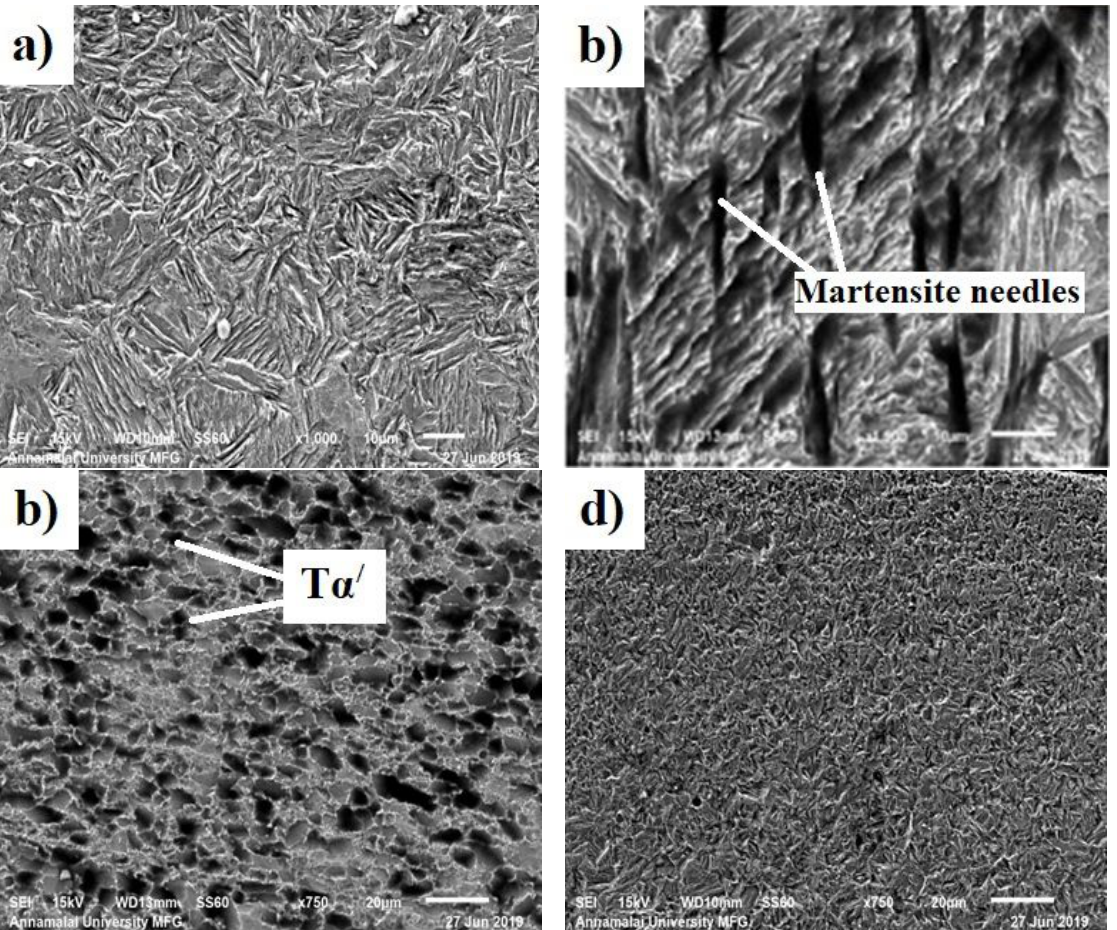
Figure 12: SEM micrograph of different regions of weld nugget: a) nugget zone at lower magnification; b) nugget zone at higher magnifica- tion; c) CG-HAZ; d)